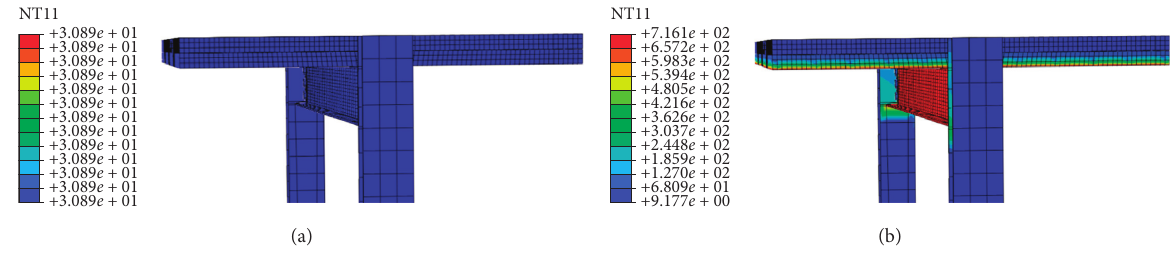
Figure 13: Temperature contours of SCB-2 (a) at 0 min and (b) at 75min.